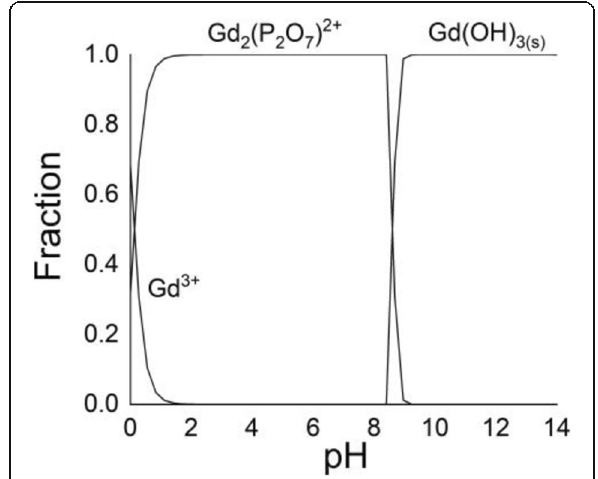
Fig. 4 Specie distribution diagram of Gd 3+ as a function of pH in the (P 2 O 7 ) 4 − system at 25 °C